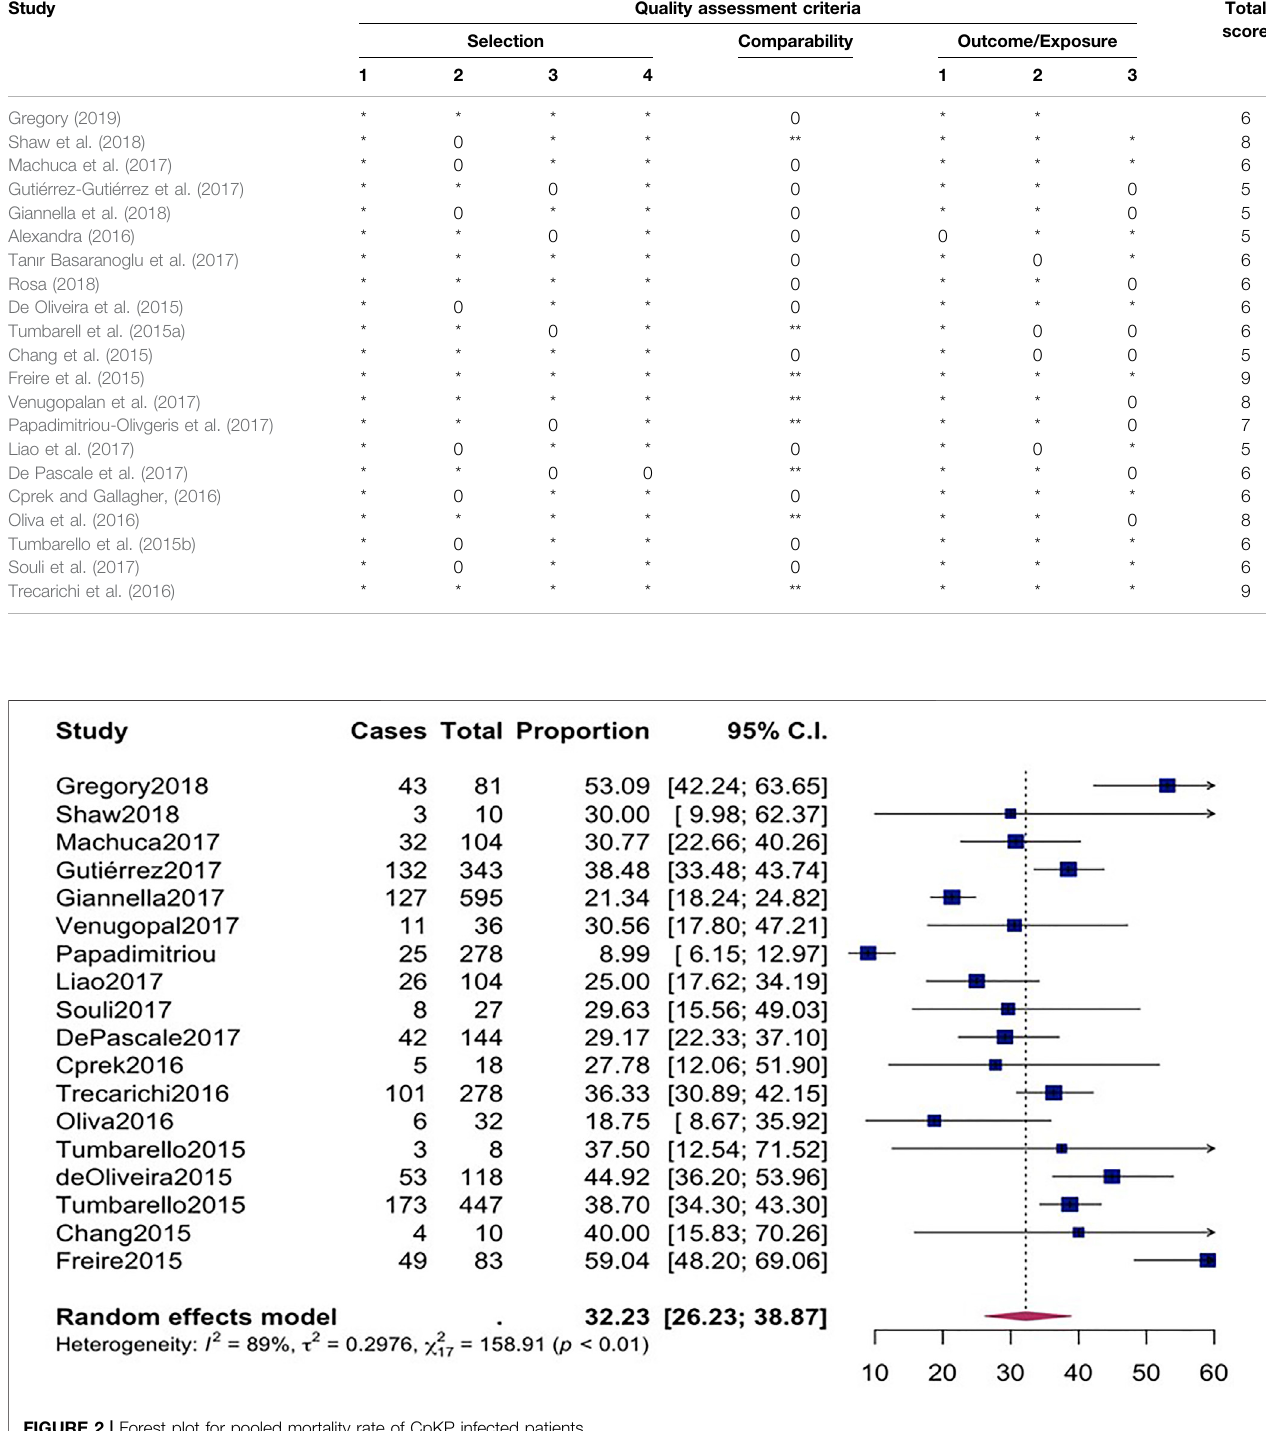
FIGURE 2 | Forest plot for pooled mortality rate of CpKP infected